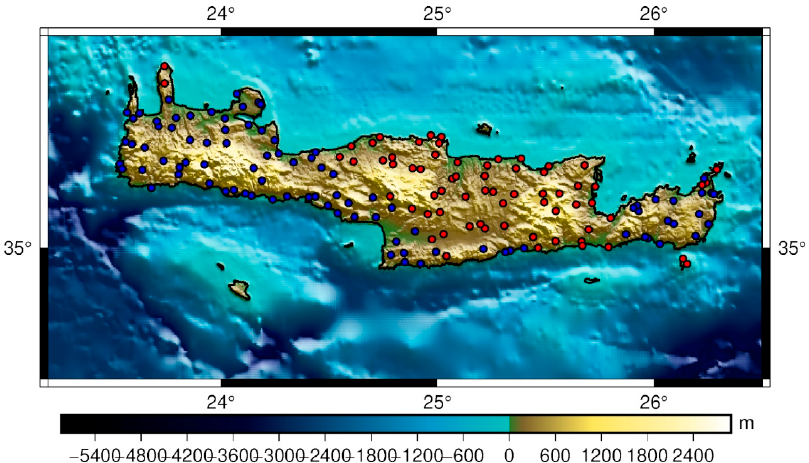
Figure 18. GNSS/levelling BMs over Crete with improved differences when using the LSC com- bined model (blue dots) and BMs where the LSC with land gravity is better (red dots).